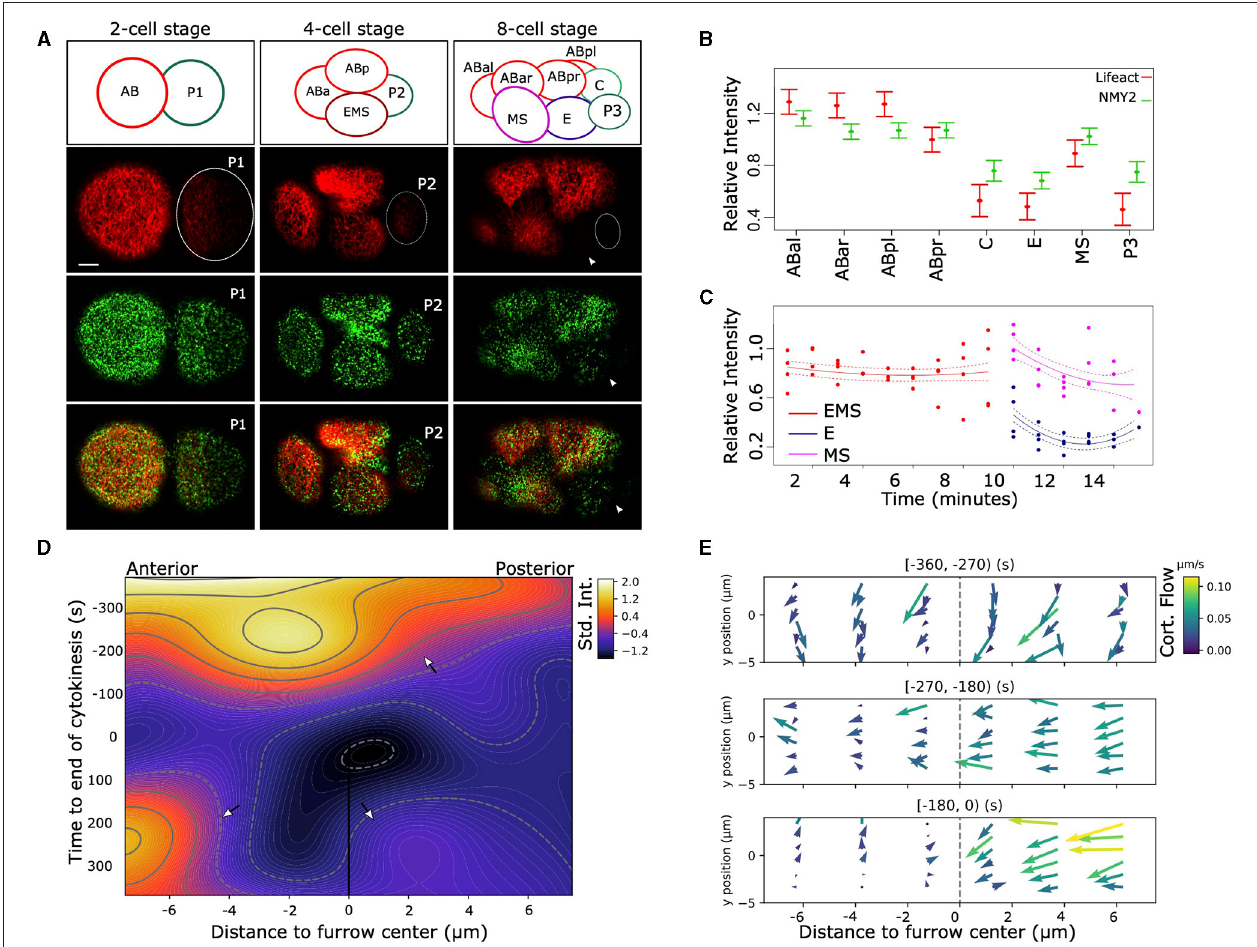
FIGURE 1 | Asymmetric distribution of F-actin and NMY-2 in the early C. elegans embryo. (A) Asymmetrical distribution in the amount of F-actin (Lifeact, red) and non-muscular myosin (NMY-2::eGFP, green) can be observed after the first, second, and third round of divisions. At the two-cell stage, AB (left) has higher signal than P1 (dotted circle), and the P1 descendants EMS and P2 (dotted circle) have lower signal than the AB descendants (left and top). The top row of figures indicates the positions and names of the cells. At the eight-cell stage, the P2 descendants P3 (right, very dim, dotted circle) and C (not visible), as well as EMS descendant E (arrowhead) have lower signal than the AB descendants (ABal bottom-left, ABar top-left, and ABpr top-right). Bar indicates 5 µ m (first image at the bottom). (B) Quantification of the cortical signal of NMY-2 and F-actin in the cells at the eight-cell stage. Data represent four embryos measured over time and are normalized for differences in intensity between dyes, embryos, background signal, imaging depth, the effect of bleaching due to imaging, and corrected for repeated measures (see section 2). F-actin and NMY-2 behave roughly similar, though NMY-2 differences are smaller. Both signals are asymmetrically distributed in the EMS daughters E and MS, with markedly lower signal in E ( p < 0.005). Error bars represent standard error around the mean. (C) The relative F-actin signal changes abruptly during the EMS division. EMS, E, and MS cortex for four embryos are measured over time; signal is corrected for several confounders and repeated measures. (D) Heatmap representing the intensity of F-actin signal in the cortex during the EMS division to MS (anterior) and E (posterior). The heatmap represents a 2D spline fit to intensity data taken from image stacks with 5 s intervals from three embryos, corrected for systematic signal intensity differences between embryos. The furrow center (at the origin) is defined by the location of the membrane at the center of the cell at the moment of membrane closure. During cytokinesis the strong curvature of the membrane induces a temporary loss of signal from the focal planes (around t = 0). The contour lines indicated lines with identical intensity values. The top arrow highlights rapid signal loss on the posterior side of the cell. The lower left arrow points to the signal in MS, lower right the much lower signal in the E cell. (E) The cortex of EMS shows large differences in cortical flow between the anterior and posterior sides relative to the cytokinetic furrow. The data is based on manual tracking of cortical features of three embryos. Image stacks are 5 s